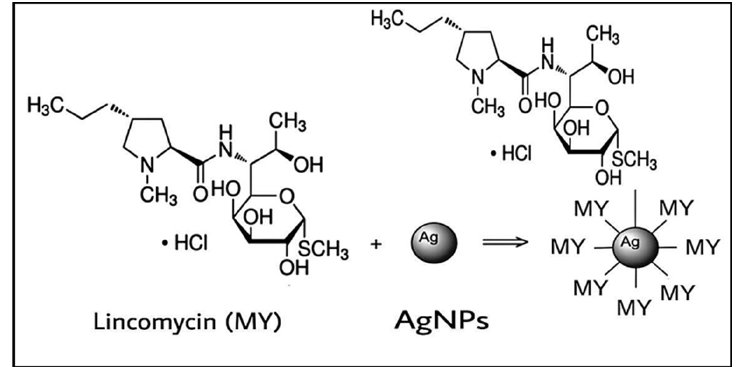
Figure 7. Chemical interaction of lincomycin with AgNPs.